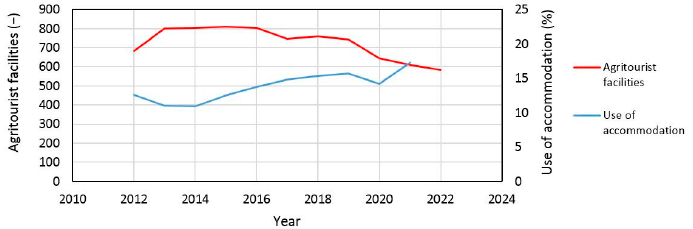
Figure 29. Agritourism facilities in rural Poland and use of available accommodation in 2012–2022, according [66].